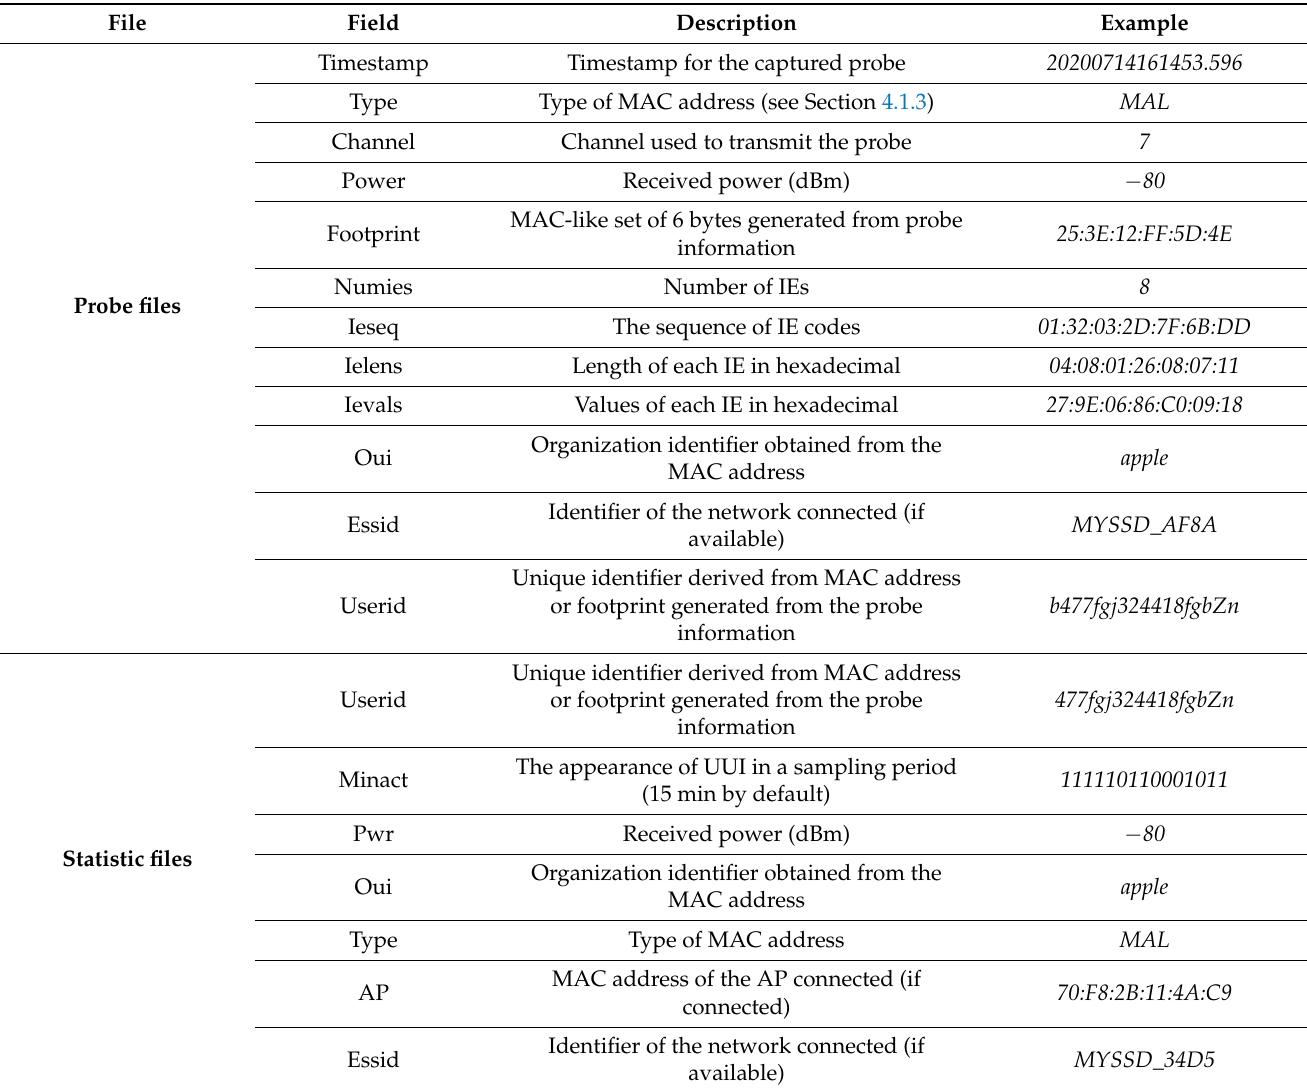
Table 1. Fields of the CSV files generated from captured